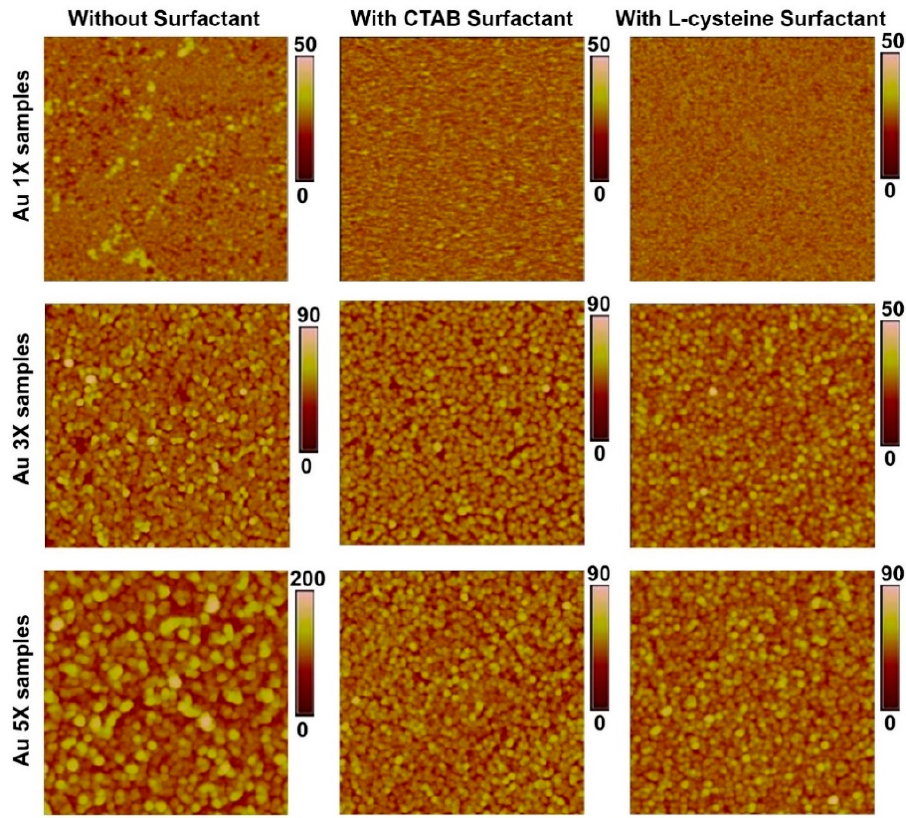
Figure 8. Representative AFM topography maps of the Au samples after one (1X), three (3X), and five (5X) deposition cycles. Scan area of 2 µ m × 2 µ m. Height scale is in nm.